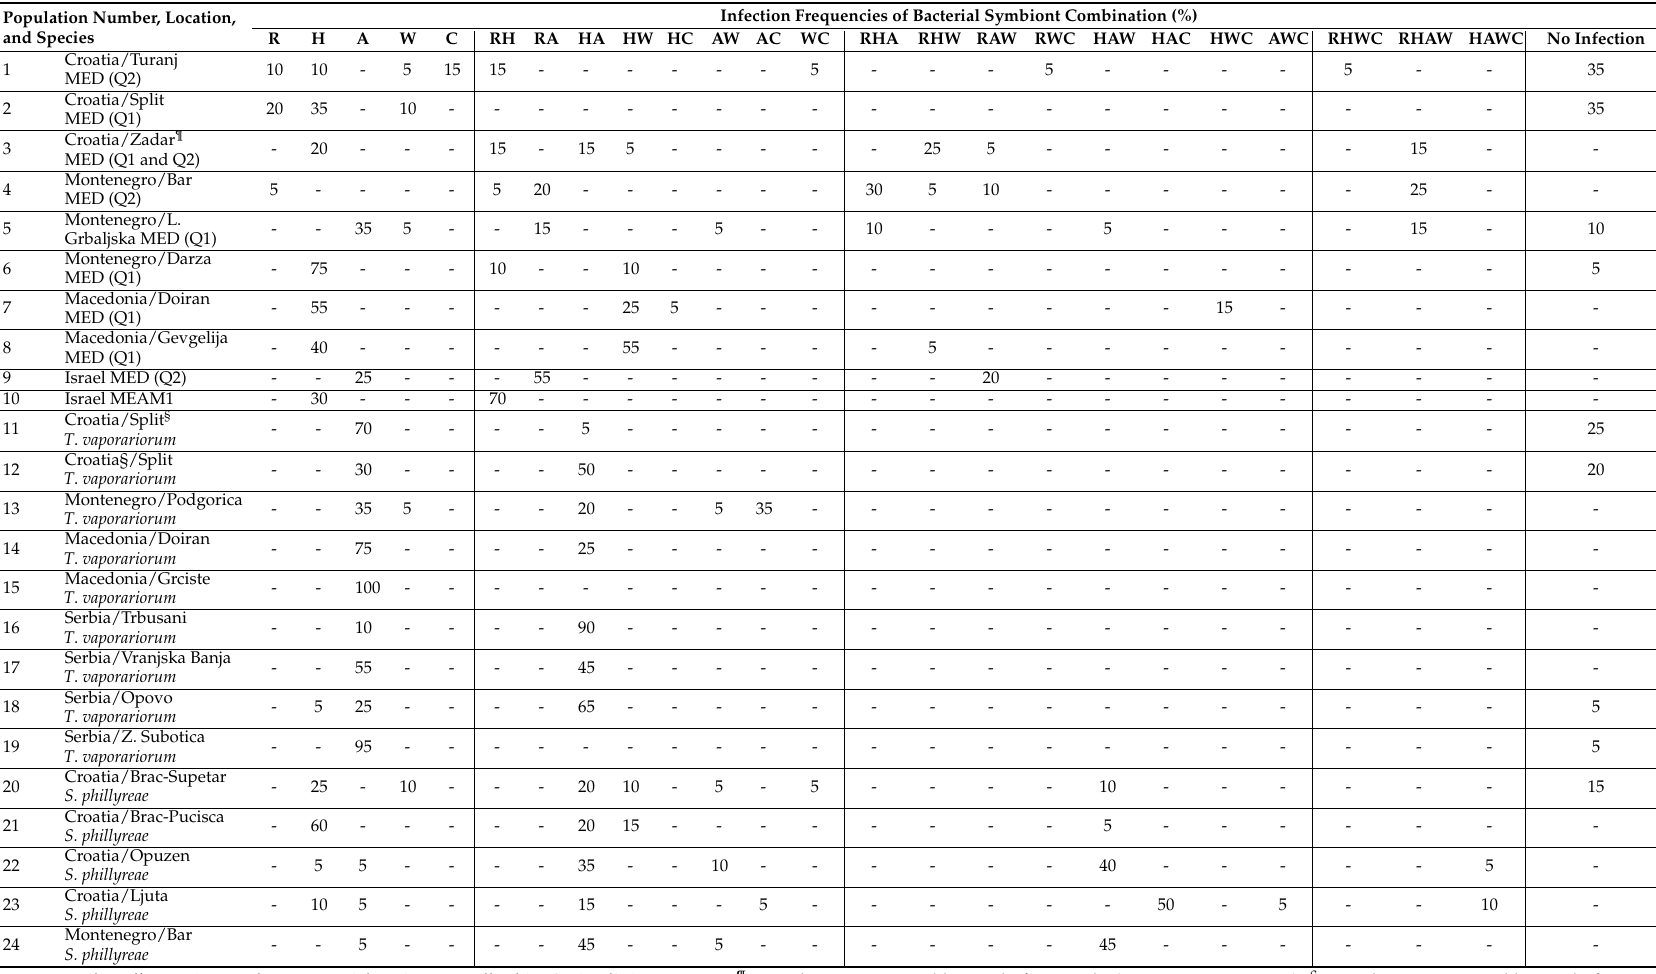
Table 3. Infection frequencies of different secondary bacterial symbiont combinations in the three whitefly species in this study. Population Number, Location, and